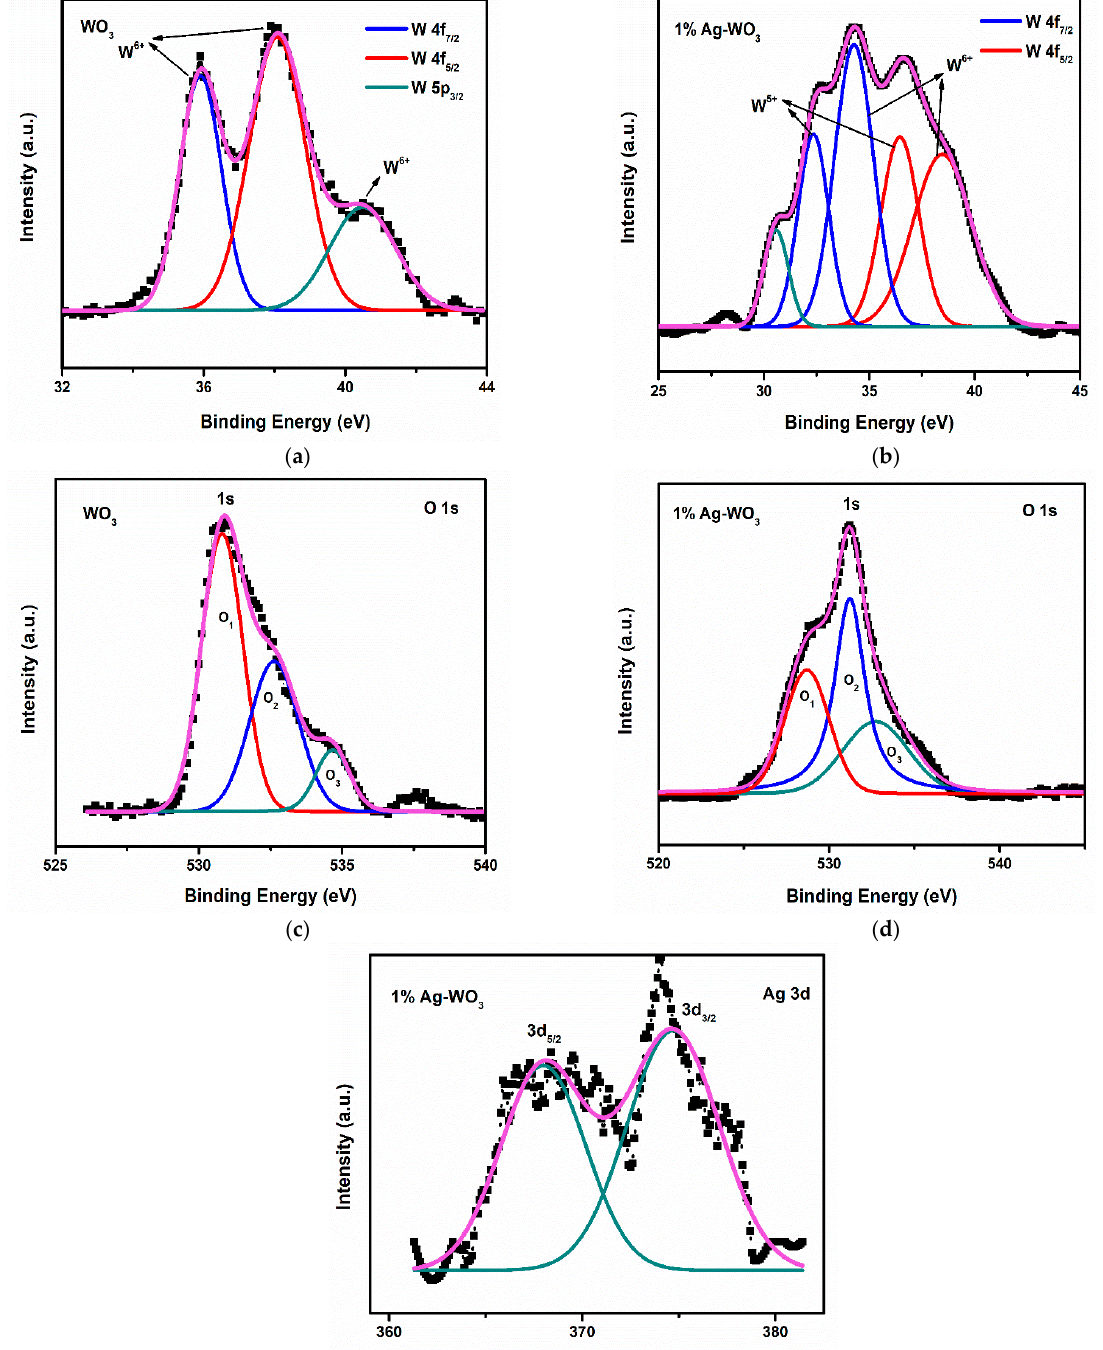
Figure 5. ( a – e ): XPS spectra of W, O, and Ag core levels in WO 3 and 1% Ag–WO 3 films.